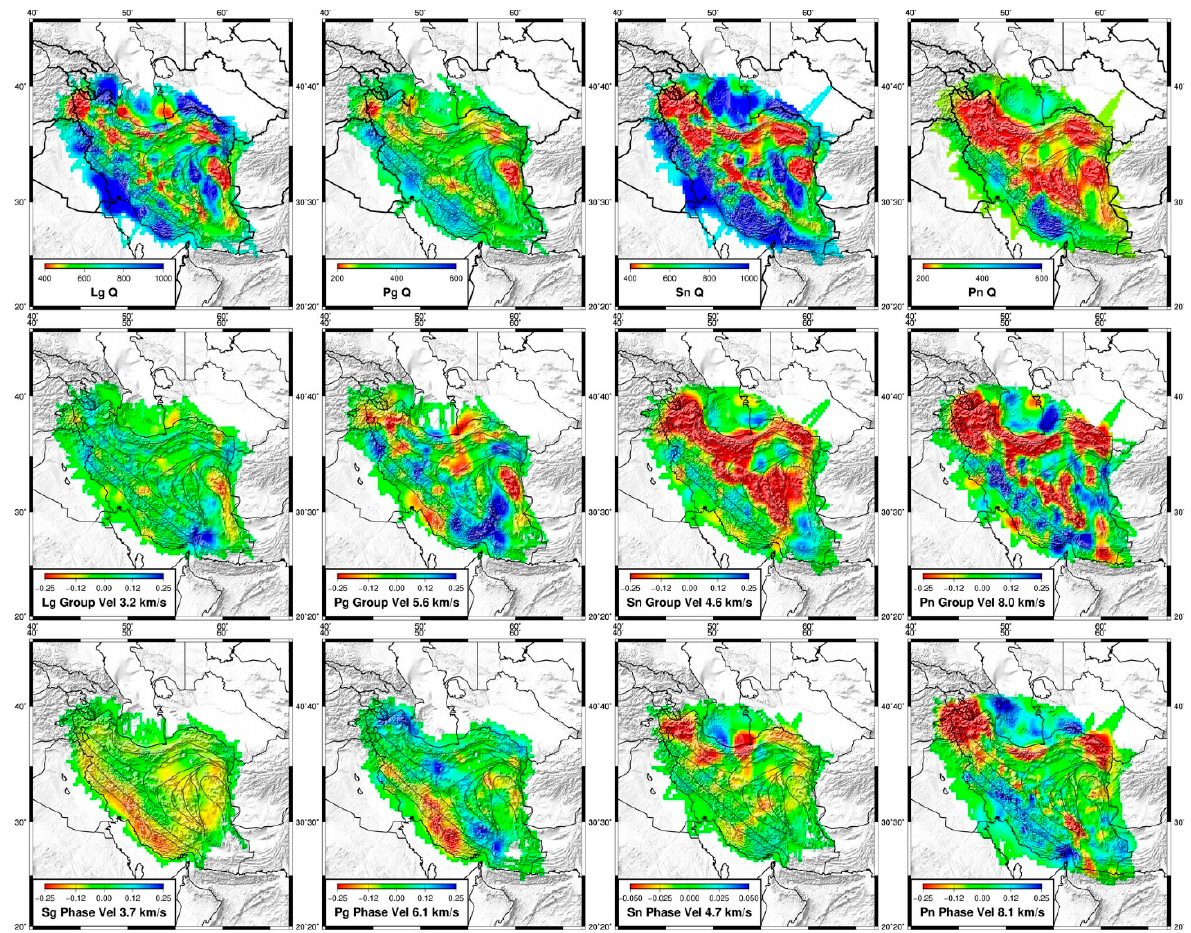
Figure 5. Velocities and attenuation. Top plots are the attenuation, middle plots are of group velocity, and bottom plots are of phase velocity. The color bar is stretched to produce equal contours in 1/ Q . Note the reduced velocity scale for Sn phase